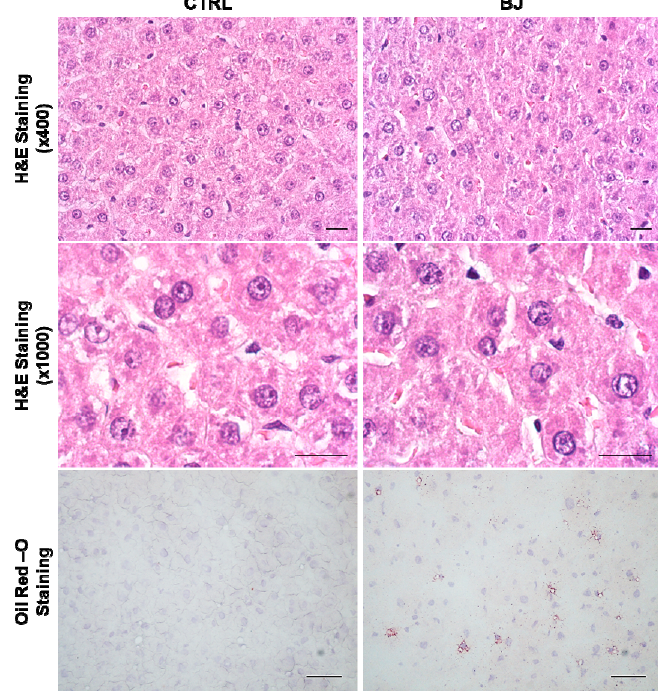
Figure 3. Representative images of hepatic structure and lipid accumulation evaluated by H&E (×400 and ×100 magnification) and Oil ‐ Red ‐ O staining (×400 magnification), respectively, in the CTRL and BJ ‐ treated rats; scale bar = 20 μ m.